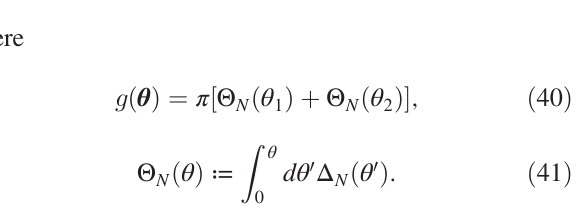
ffiffiffi p 5 Þ = 2 (the golden ratio). Figure